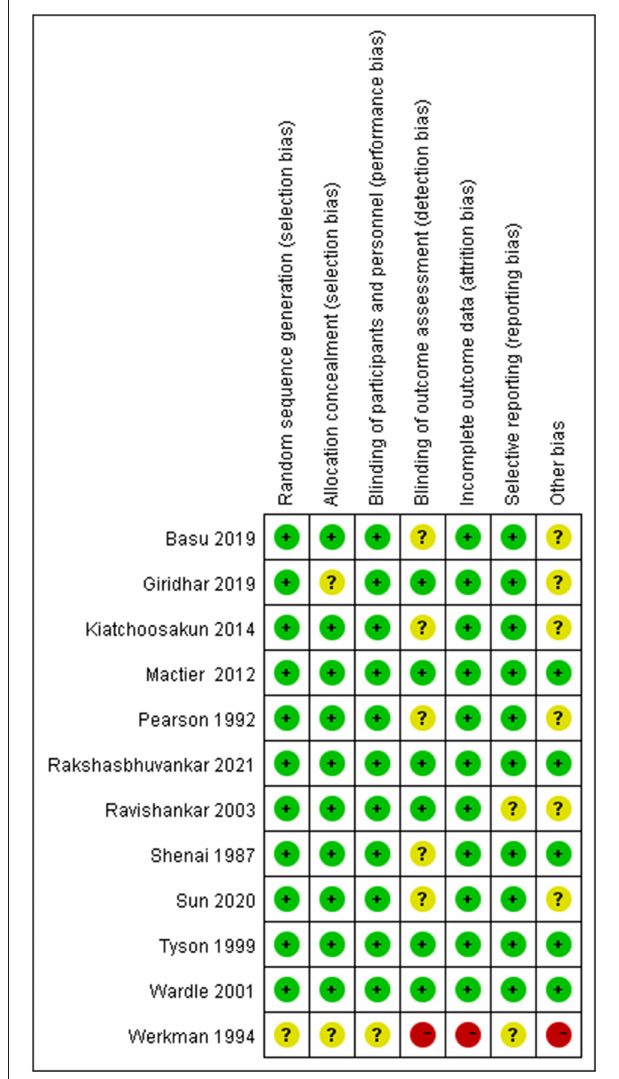
FIGURE 2 | Risk of bias